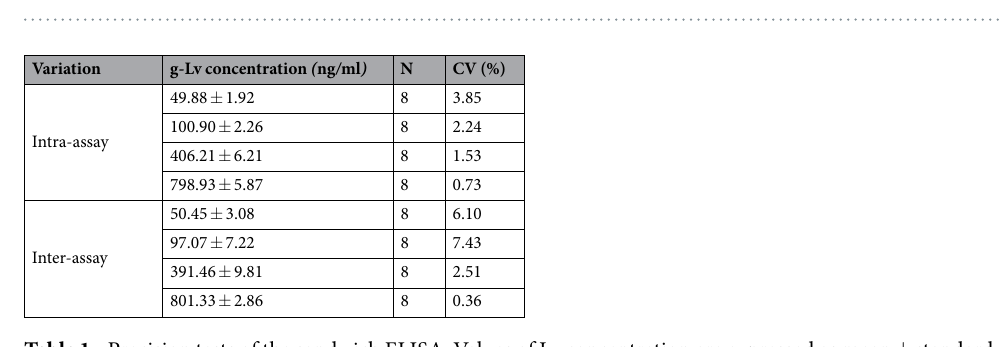
Figure 7. Determination of optimal dilution of HRP-labeled anti-Lv IgG ( A ), and a representative standard curve obtained for guppy Lv ( B ) and WBH dilution curves of control male and E 2 -exposed male guppy in sandwich ELISA ( C ).